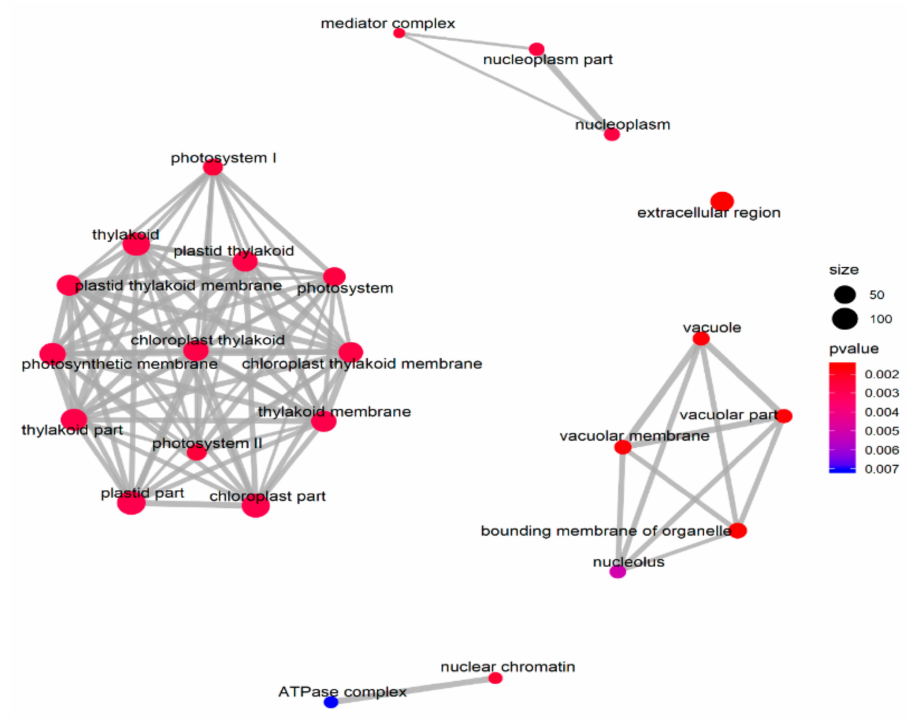
Figure 8. Network of roles of cellular components enriched in gene